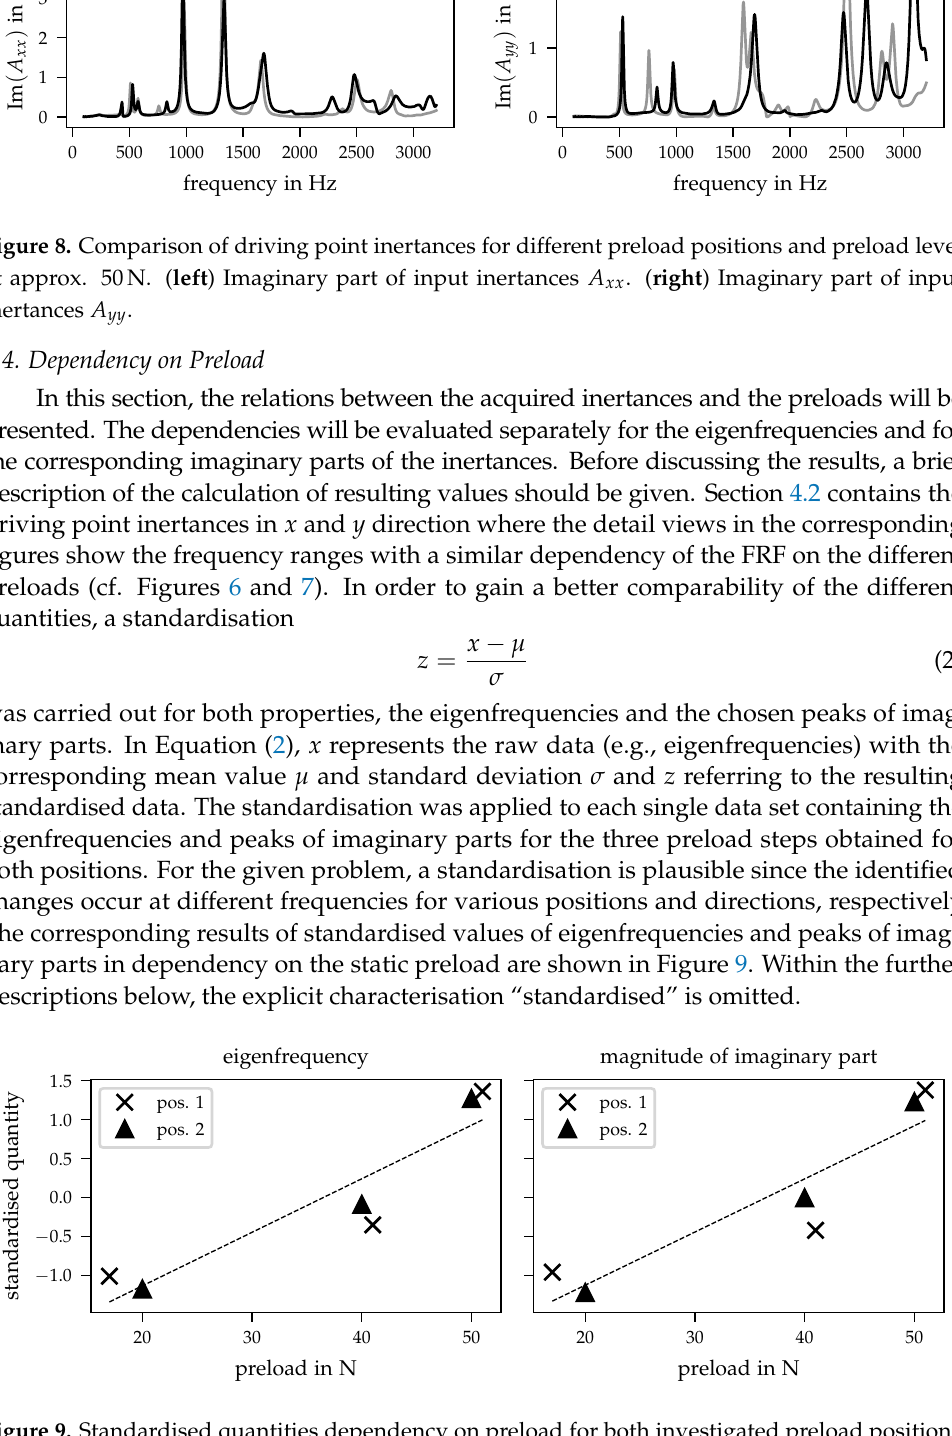
Figure 9. Standardised quantities dependency on preload for both investigated preload positions. The dashed line indicates the corresponding linear regression. ( left ) Standardised eigenfrequencies. ( right ) Standardised peaks of imaginary part of acquired